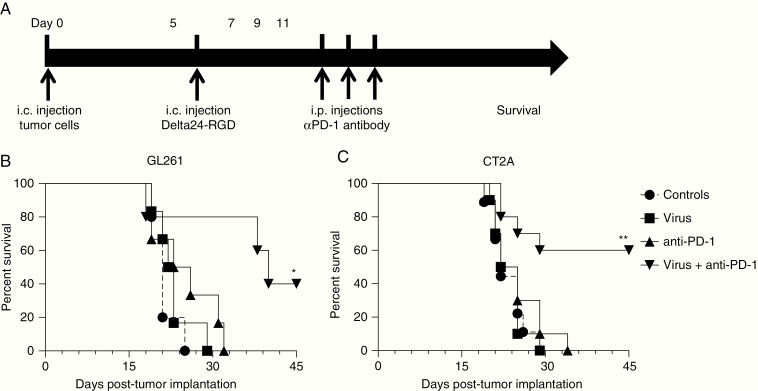
Low-dose Delta24-RGD combined with anti-PD-1 therapy significantly improves long-term survival. (A) Treatment schedule of a combination study with Delta24-RGD and anti-PD-1 antibody therapy. C57BL/6J mice were inoculated i.c. with 5 × 104 GL261 or CT2A cells and after 5 days treated i.c. with 2 × 107 pfu Delta24-RGD in 10 µL PBS and control mice were treated with 10 µL PBS. Anti-hamster PD-1 blocking antibodies (G4) or Hamster IgG (control) were injected intraperitoneally at doses of 200 µg/injection at days 7, 9, and 11 post-tumor implants. (B) Kaplan–Meier analysis showed a significant improvement of median survival to 40 days and 40% of mice surviving longer than 90 days (LTS) with combined Delta24-RGD therapy and anti-PD-1 therapy compared to all other groups in the orthotopic GL261 tumor model (P < .05). (C) Kaplan–Meier analysis showed improved overall survival (median survival undefined) and 60% LTS with combined Delta24-RGD and anti-PD-1 therapy in the orthotopic CT2A tumor model (P < .01). P values were calculated with the Log-Rank test. *P < .05, **P < .01.